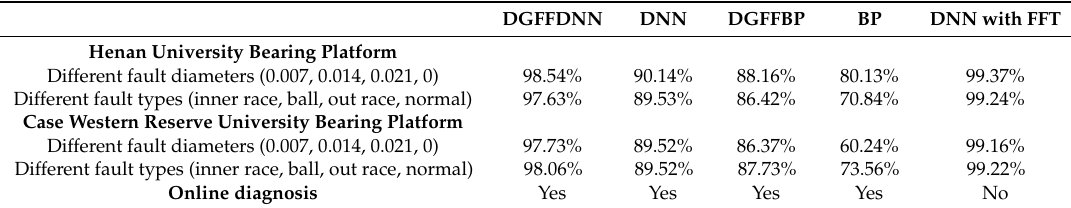
Table 4. Case study: accuracies of different fault diagnosis methods. (The unit of the fault diameter is in inch).